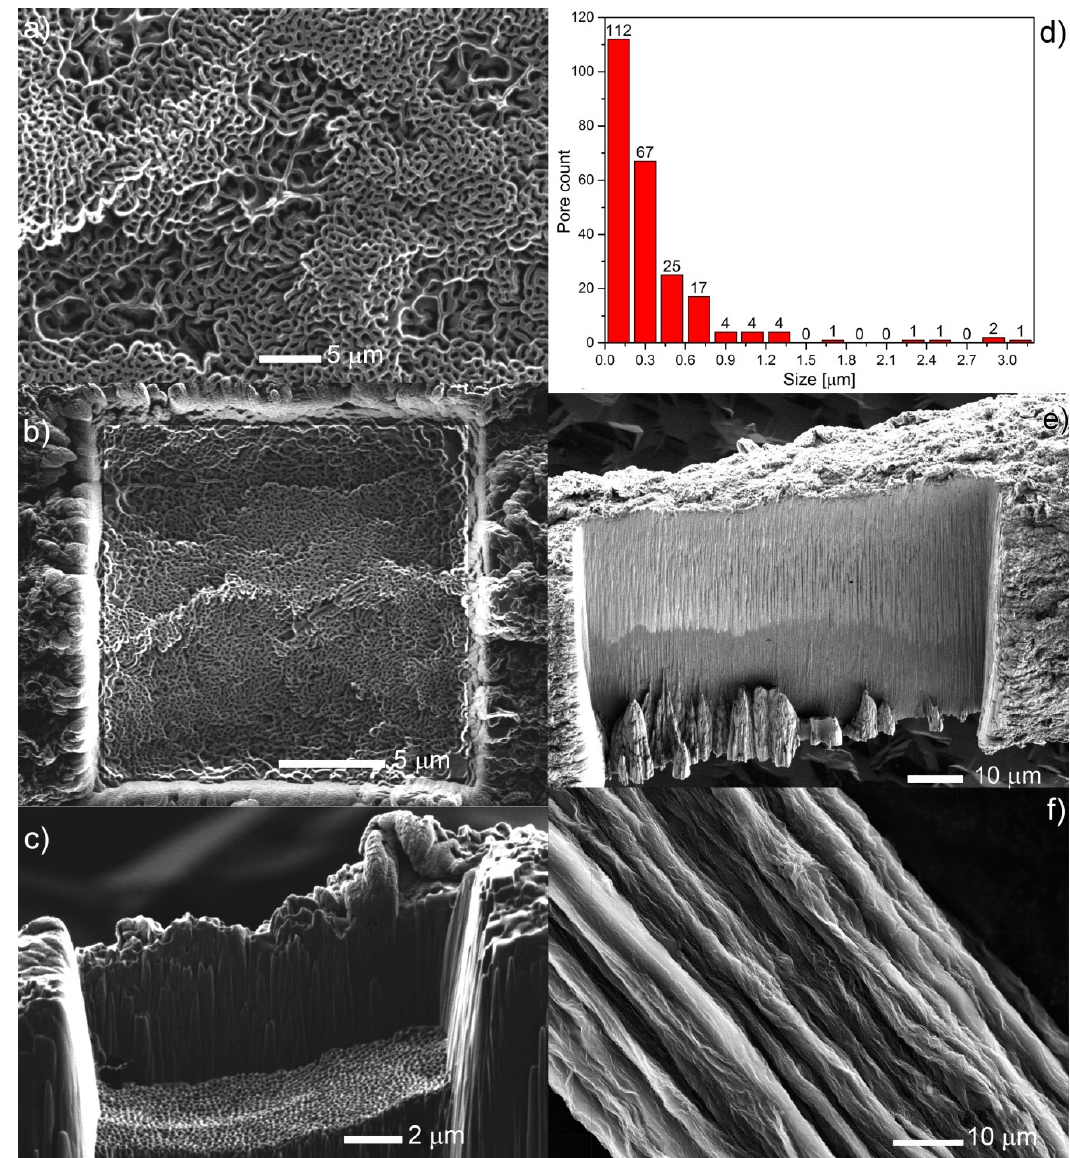
Figure 2. Focused ion beam images: ( a ) inside of the milled square from ( b ); ( b ) milled with gallium ions square on side of the fiber-view in the axis of Ga stream direction; ( c ) side view of a milled fiber; ( d ) pore sizes distribution taken from ( a ); ( e ) milled fiber-view perpendicular to Ga stream direction; ( f ) SEM micrograph of the fibers surface.